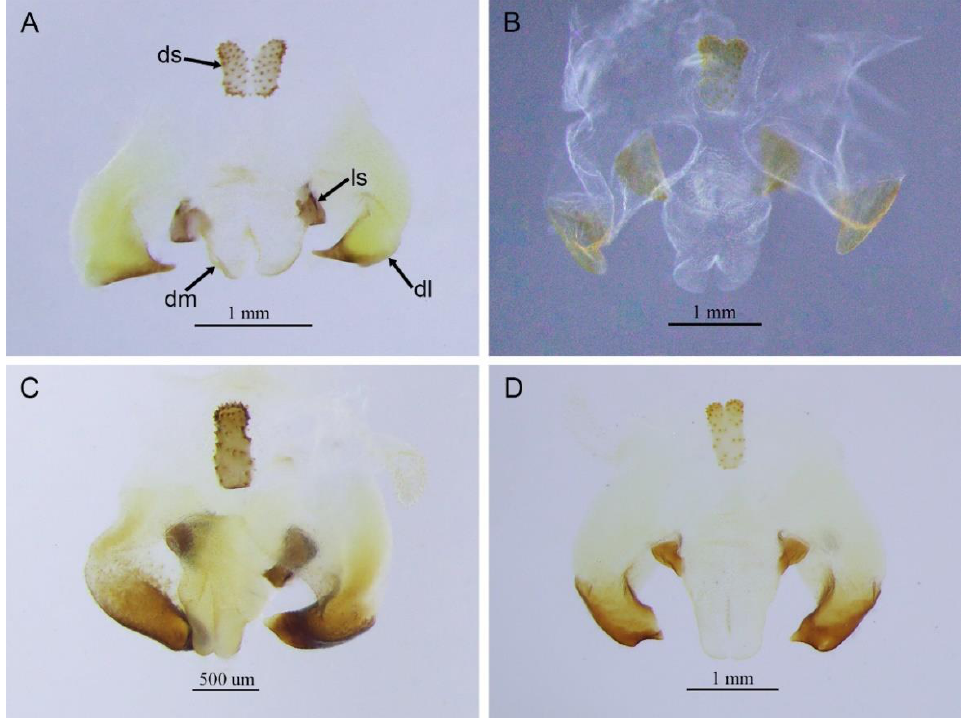
Figure 2. Male genitalia of Gymnaetoides (type specimens). ( A ) Gymnaetoides testaceus ; ( B ) Gymnaetoides deformus comb. nov.; ( C ) Gymnaetoides inermus comb. nov.; ( D ) Gymnaetoides yueyangensis comb. nov. Abbreviations: ds = dorsal sclerite; ls = lateral sclerite; dm = dorsal median lobe; dl = dorsal lateral lobe.